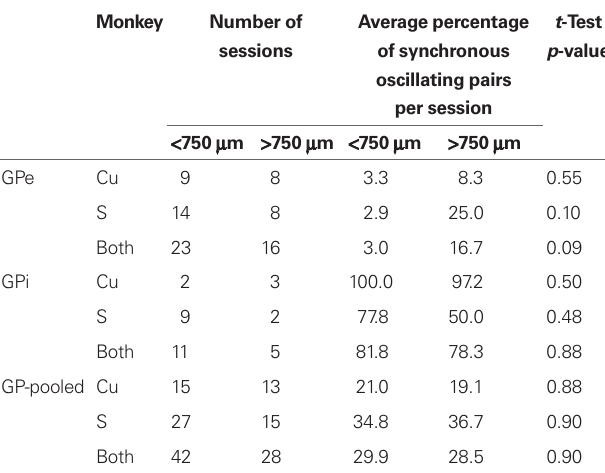
Table 5 | Average percentage of synchronous oscillating pairs per session in two distance categories.